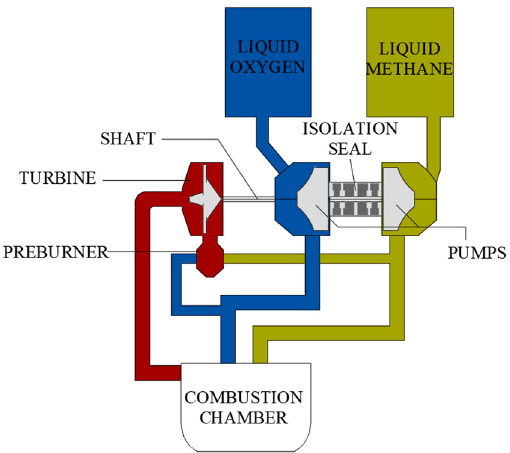
Figure 1. Schematic diagram of a rocket’s liquid -fuel pump.